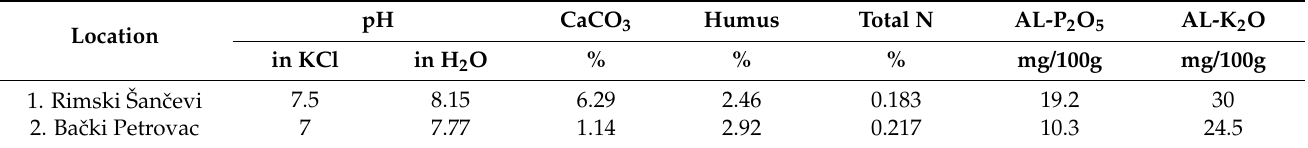
Table 2. Soil fertility parameters for both locations at the beginning of the field trials.